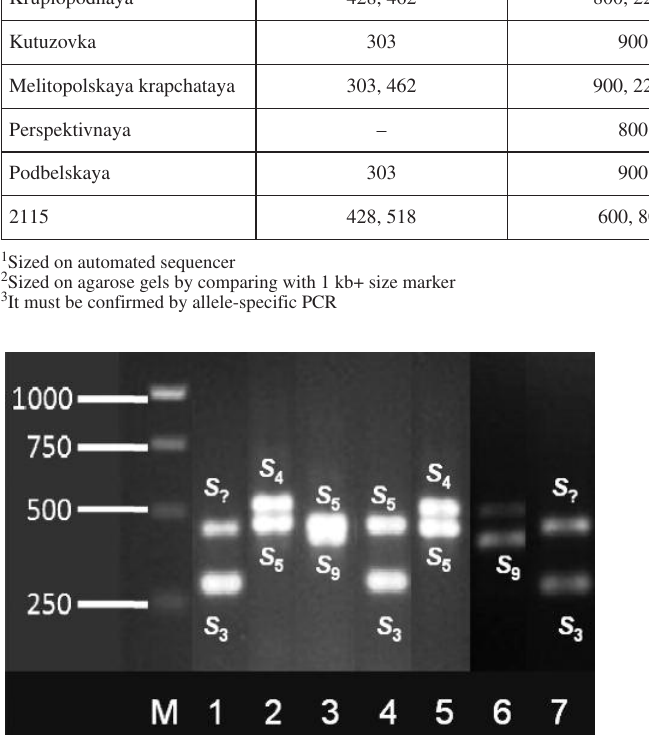
Figure 3: PCR analysis of Ukrainian sweet cherry cultivars with the PaConsI-F and -R primers amplifying the first intron region of the Prunus S-RNase gene. M: 1kb+ DNS marker, 1. ‘Podbelskaya’, 2. ‘Kodrinskaya’, 3. ‘Krupnoplodnaya’, 4. ‘Melitopolskaya’, 5. ‘Junskaya rannaya’, 6. 2115, 7. ‘Kutuzovka’. The PCR of ‘Perszpektivnaya’failed